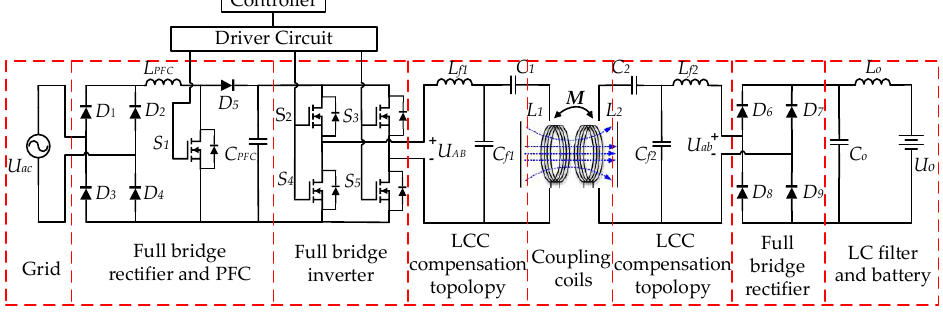
Figure 2. Circuit structure of WCS.